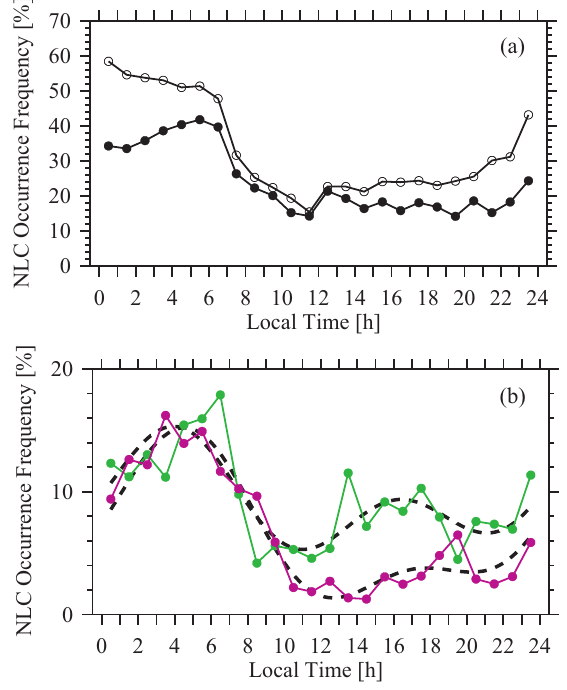
Fig. 2. Diurnal occurrence of NLC above ALOMAR for the inte- grated data set from 1997 to 2003, sorted by brightness classes. ( a ) β max > 0 (black hollow circles) and β max > 4 (black filled circles). ( b ) β max :4 − 7 (green circles) and β max > 13 (magenta circles). The brightness values are in units of 10 − 10 m − 1 sr − 1 , the dashed curves are harmonic fits to the data.